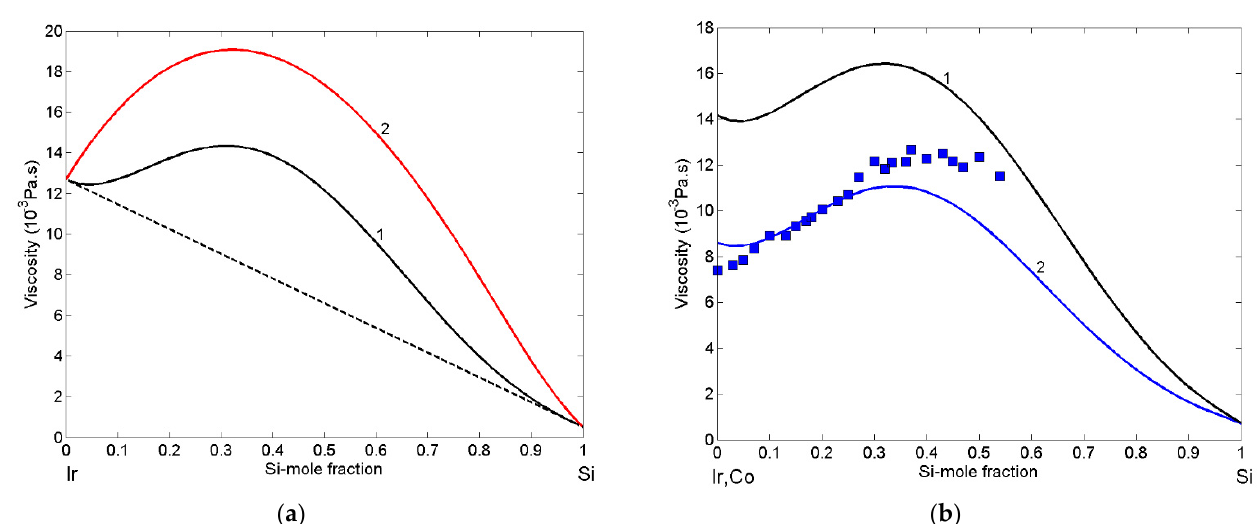
Figure 7. ( a ). Viscosity isotherms of liquid Ir-Si alloys for T = 1873 K calculated by Moelwyn-Hughes’s model (curve 1) and Terzieff’s model (curve 2). (------) the additive rule. ( b ) Viscosity isotherms of liquid Ir-Si (curve 1) and Co-Si (curve 2) alloys calculated by Moelwyn-Hughes’s (MH) model for T = 1773 K. For a comparison, the Co-Si viscosity isotherm (curve 2) and datasets ( ) [68] are shown.